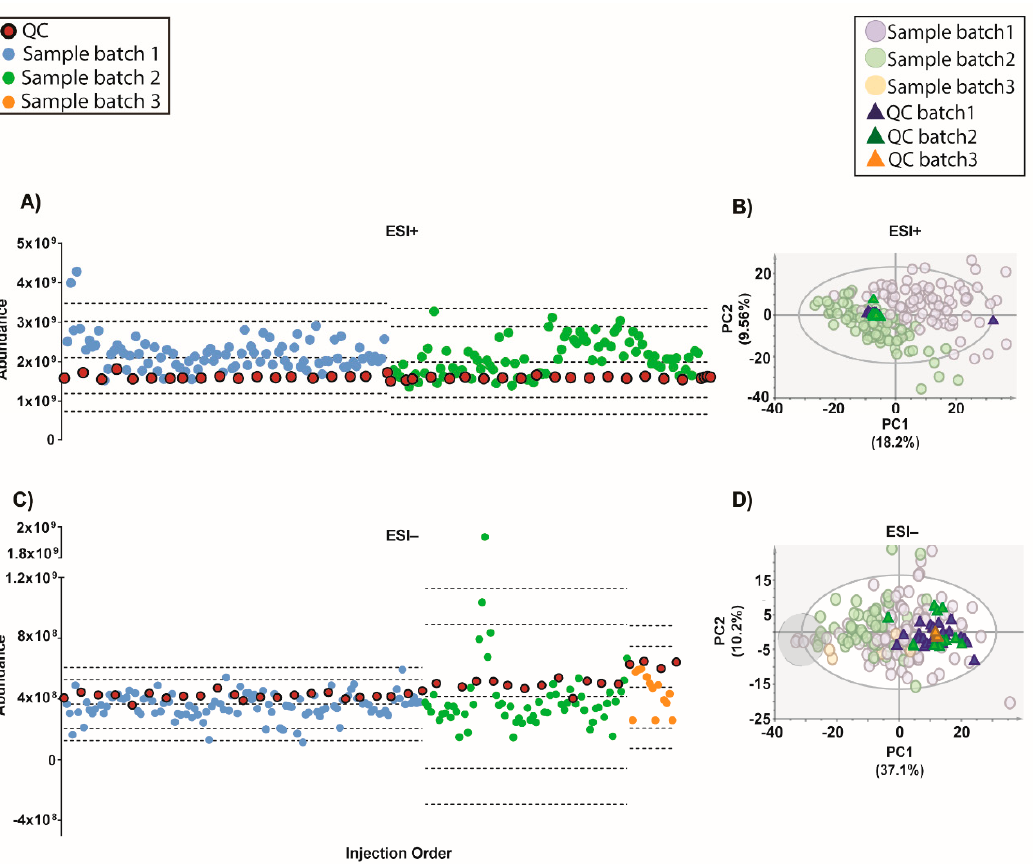
Figure 4. Outcome of the data normalization strategy after QC-SVRC algorithm for both ESI + and ESI − modes. ( A , C ) Quality control chart of ESI + and ESI − modes. Samples with a TUS higher than 3 SD of the mean or lower than − 3 SD were removed from PCA model. ( B , D ) PCA plots of ESI + and ESI − mode, respectively Signals with %RSD < 30% on QCs were kept, and UV scaling was used. Features in ESI + and ESI − modes, respectively: 1056 and 394. Legend . TUS plot : Blue and green dots: samples of batch1 and batch2, respectively, red dots: QCs. Dotted lines represent the mean +/ − 2 and 3 SD for each batch independently. PCA : Blue dots and dark blue triangles are samples and QCs measured in batch1, respectively; green dots and dark green triangles are samples and QCs from batch2, respectively. Grey circle are samples with low levels of IS mix.